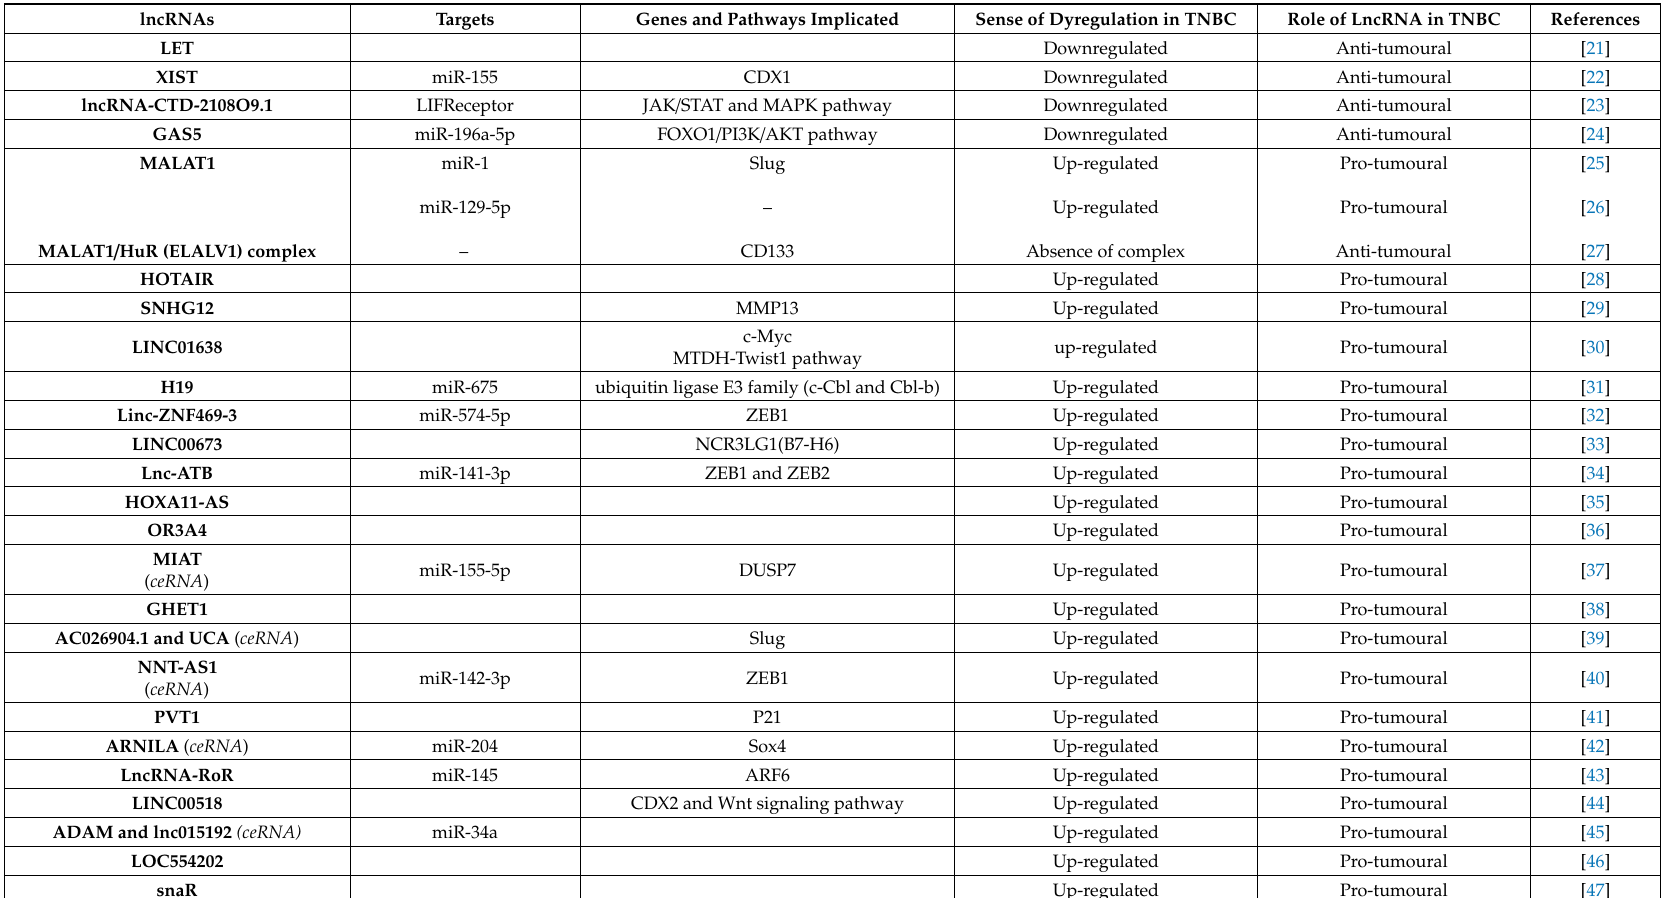
Table 1. Significant lncRNAs implicated in EMT of